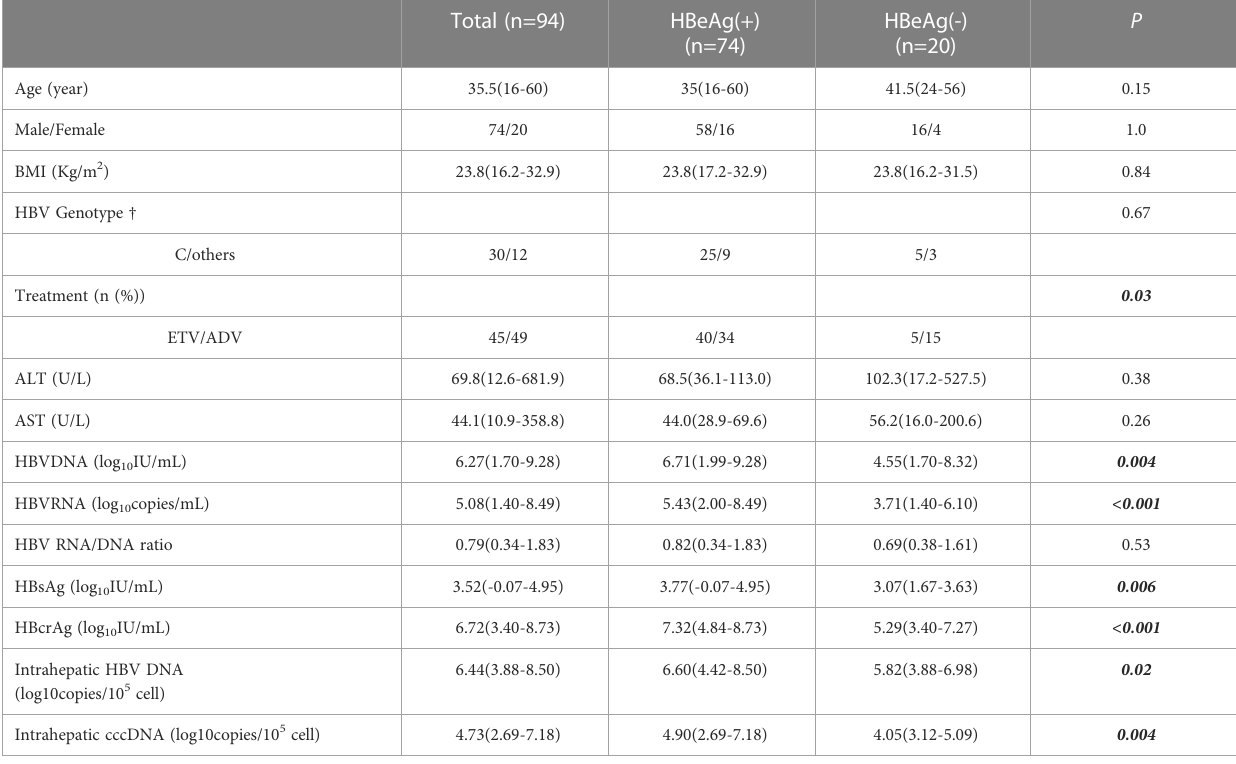
TABLE 1 Baseline characteristics of the